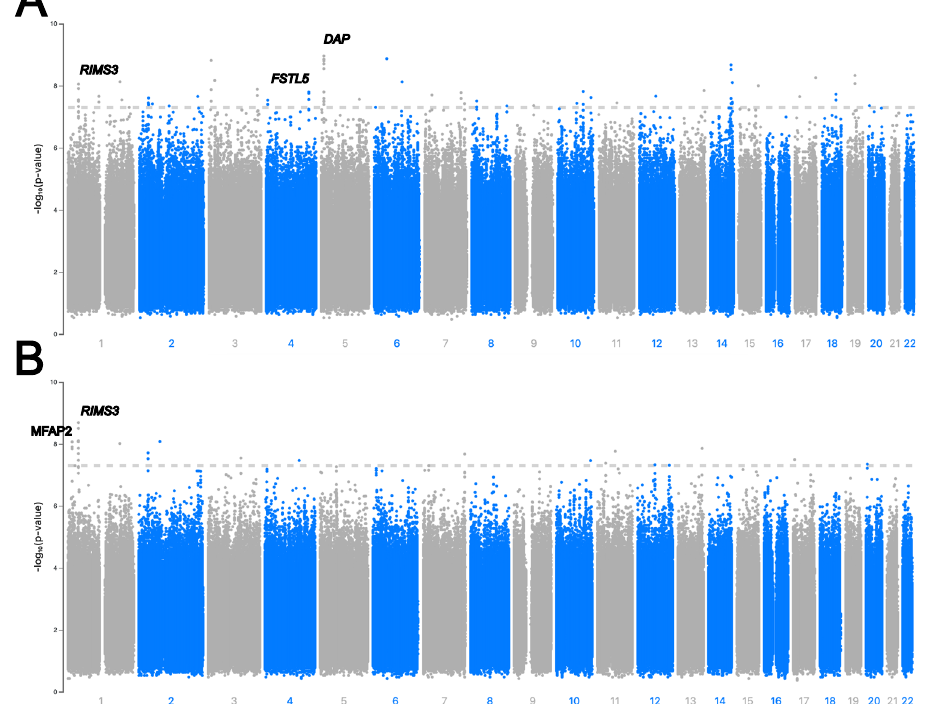
Fig. 2 | Results fromthegenome-to-genome comparison ofhost and pathogen data. A Manhattan plot showing the – log10 ( P value) for each human variant. Resultsare plotted by chromosomes with alternating grey and blue colouring. The